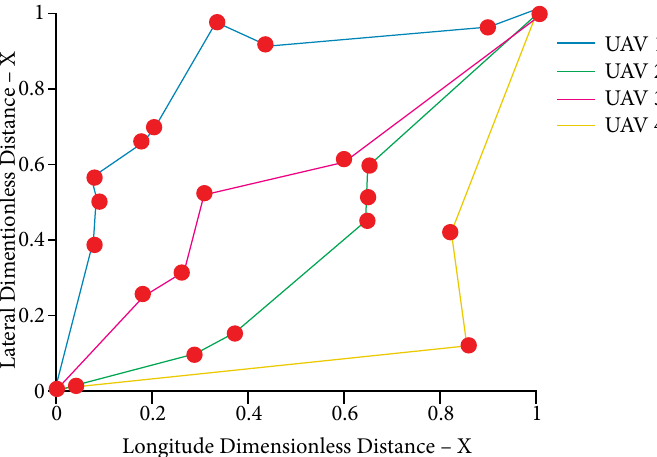
Figure 9. The optimal path for 4 UAVs patrolling, the average traveling distance is 1.6264.